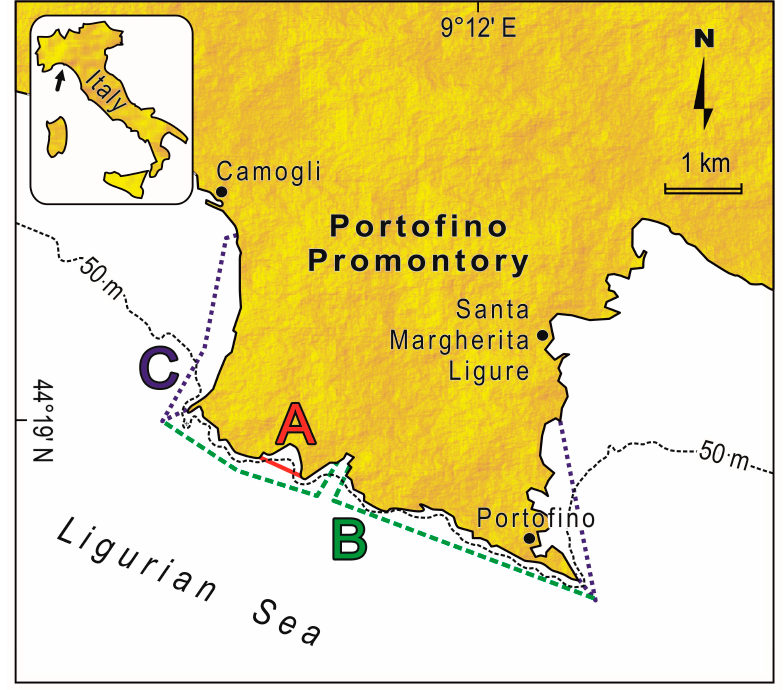
Figure 3. Geographic situation of the study area: the Portofino promontory in northwest Italy (see arrow in the inset). Capital letters denote the three zones of the marine protected area of Portofino subject to di ff erent levels of protection: the A zone is the “no entry, no take” area; the B zone is the general reserve; the C zone is the partial reserve. The three municipalities of the Portofino Promontory are also